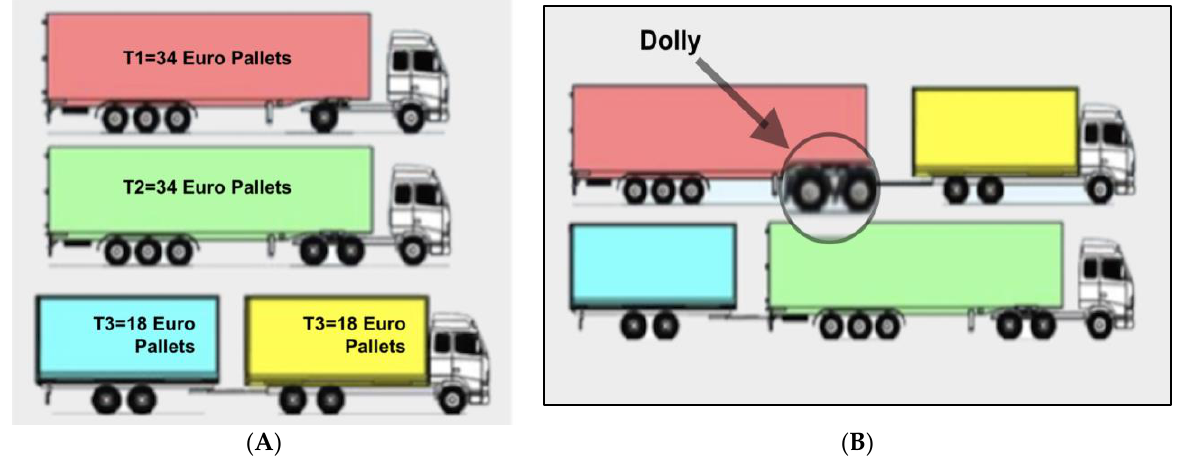
Figure 2. ( A ) Standard trucks (present situation); ( B ) Combining the standard trucks from ( A ) into two LCVs. The upper LCV uses a dolly. This specific setting is used in our case study.